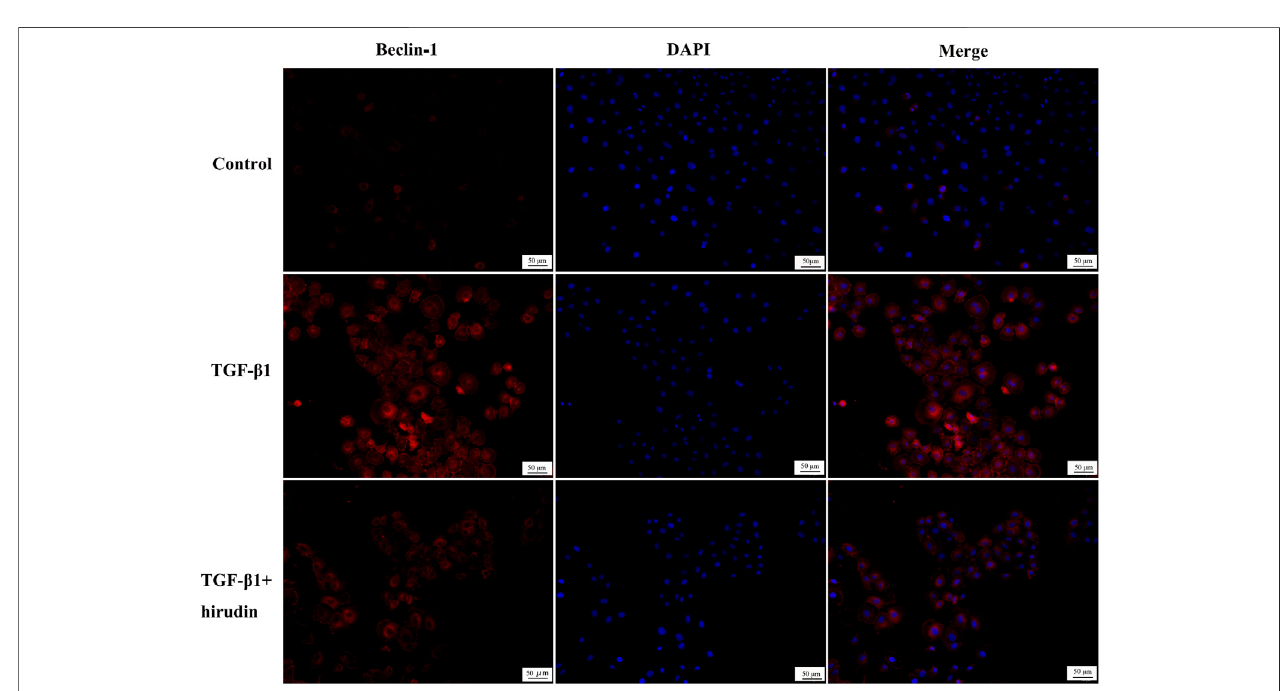
FIGURE 9 | Cellular immuno fl uorescence detection of Beclin-1 protein expression.